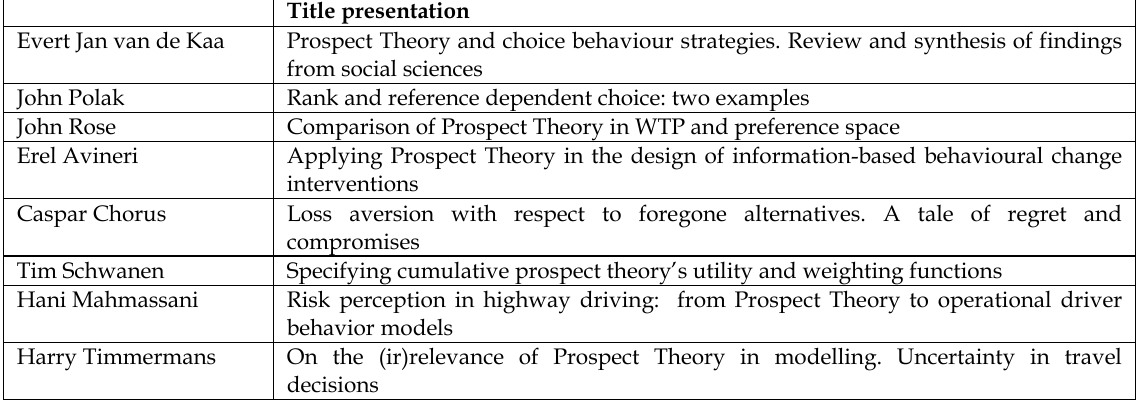
Table 1: an overview of speakers and presentation